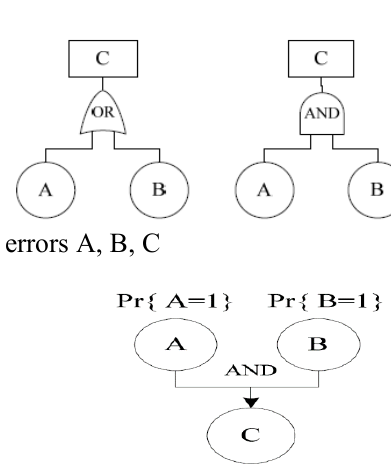
Figure 2. Bayesian network related to the fault tree with AND gate